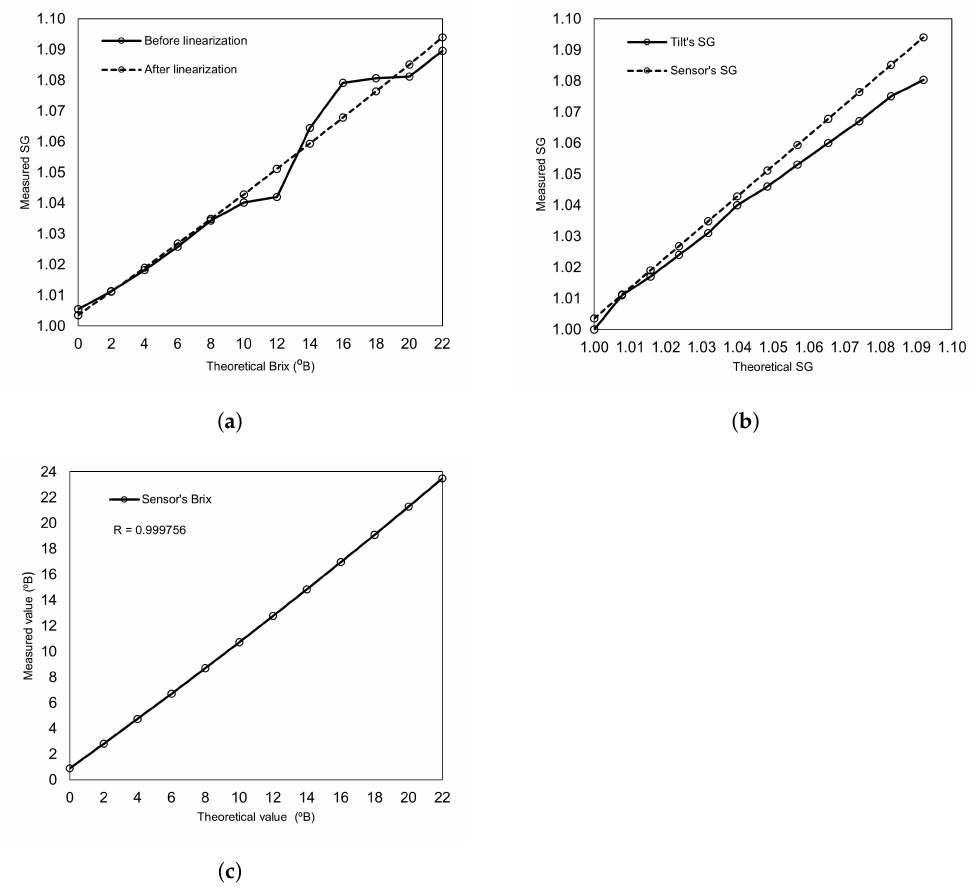
Figure 6. Measurements plots from the sugar monitoring experiments. ( a ) Linearization of the proposed Brix sensor; ( b ) SG values of the proposed sensor and Tilt hydrometer; ( c ) Brix measurement results (theoretical vs.